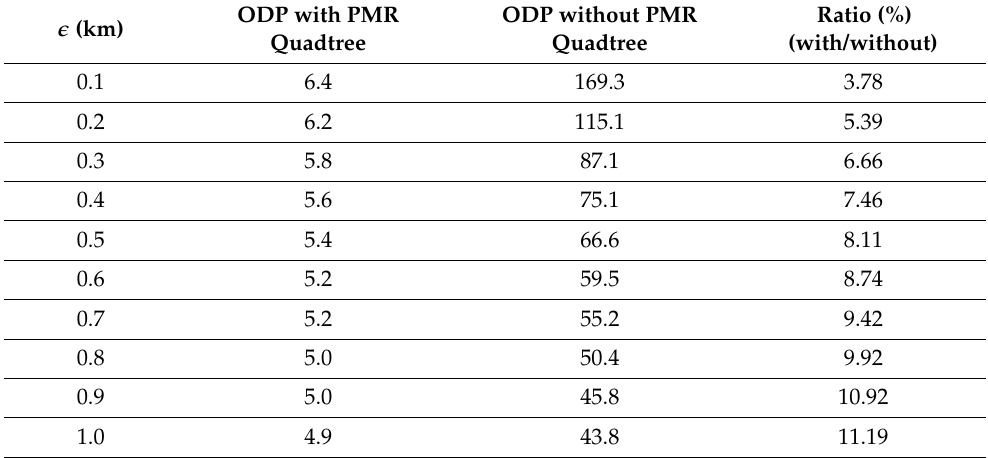
Table 5. Comparison of the computational efficiencies of the ODP algorithms with and without the PMR quadtree (Trajectory 1).